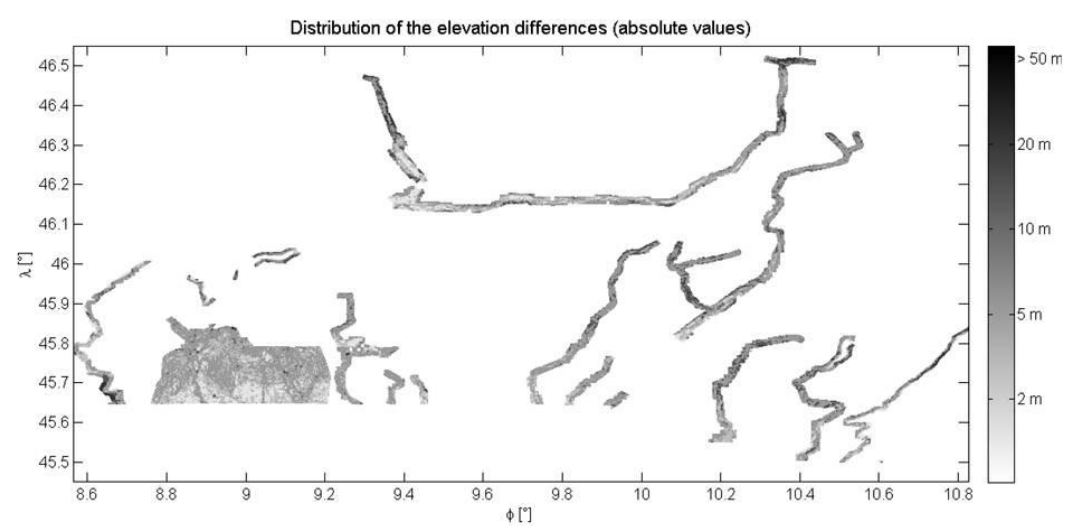
Figure 1. Map of the height differences between HR and LR DTMs in San Giacomo Valley.